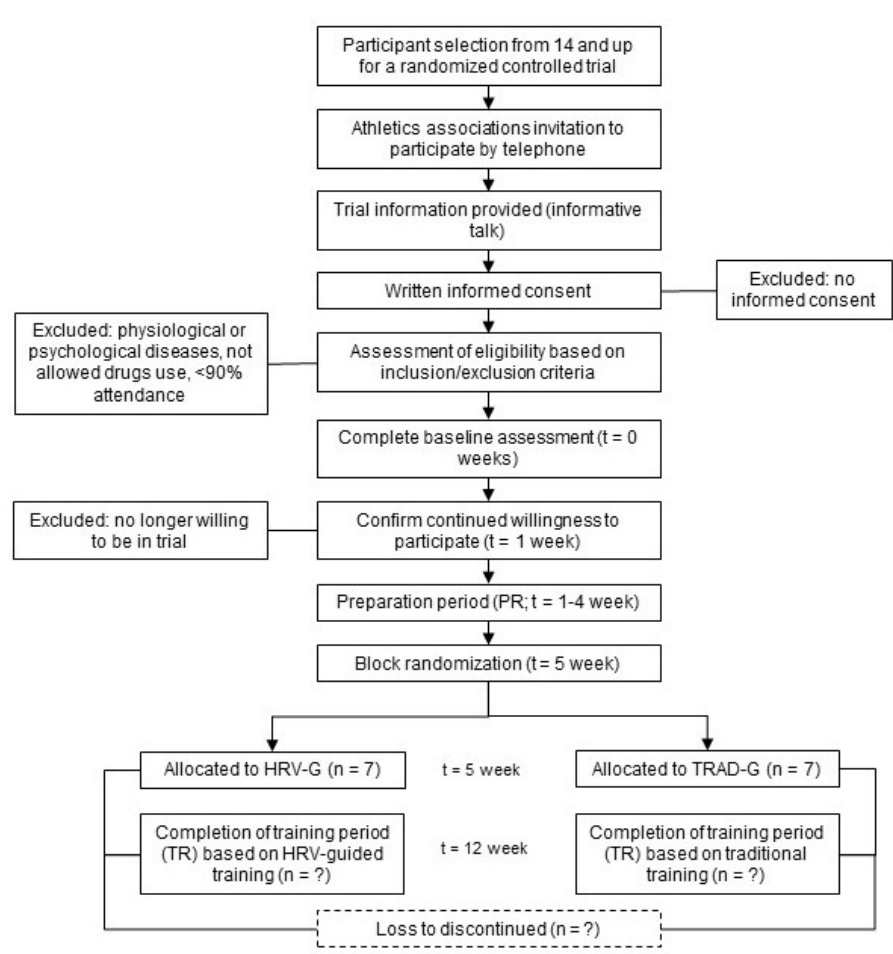
Figure 2. Schedule of enrolment, interventions and assessment. Note: HRV-G = heart rate variability-based training group; TRAD-G = traditional based training group; PR = preparation period; TR = training period.